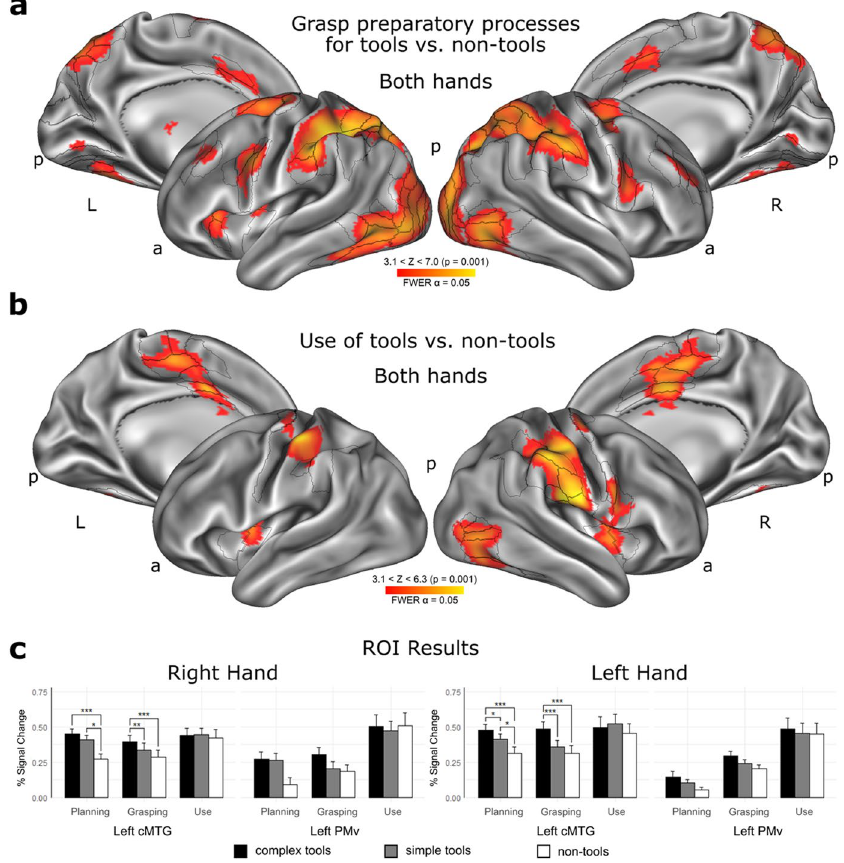
Figure 3. Brain areas involved in planning, grasping and using of complex and simple tools. ( a , b ) Task-related contrasts revealing significantly different clusters of voxels, thresholded at least at Z > 3.1, and a cluster-corrected (family-wise error rate, FWER controlled) significance threshold of p ≤ 0.05, for ( a ) planning functional grasps of tools (grasp preparatory processes) contrasted with non-tools, and ( b ) tool use contrasted with pointing movements with non-tools, regardless of the used hand. ( c ) ROI (region of interest) analyses in the left caudal middle temporal gyrus (cMTG) and ventral premotor cortex (PMv), with percent signal change (%SC) extracted from 5-mm dimeter spheres centered at coordinates of local signal peaks obtained from an independent tool use localizer (see Methods). A 3 × 3 repeated-measures analysis of variance (rmANOVA) in left cMTG revealed a significant phase (Planning, Grasping, Using) by object category (Complex tools, Simple tools, Non-tools) interaction for both tasks performed with the dominant right hand (F 4,76 = 3.491, P = 0.0113, ηp 2 = 0.155, 1-β = 0.841) and the non-dominant left hand (F 2.757,52.375 = 4.412, P = 0.0093, ηp 2 = 0.188, 1-β = 0.827). This same analyses conducted for left PMv revealed neither significant interaction for tasks performed with the right hand (F 2.054,39.023 = 2.877, P = 0.0670) nor the left hand (F 4,76 = 0.608, P = 0.658), although a similar trend was observed only for the dominant hand. Asterisks indicate significant differences with p-values of ≤ 0.05 (*), 0.01 (**), or 0.001 (***) in post hoc Bonferroni corrected